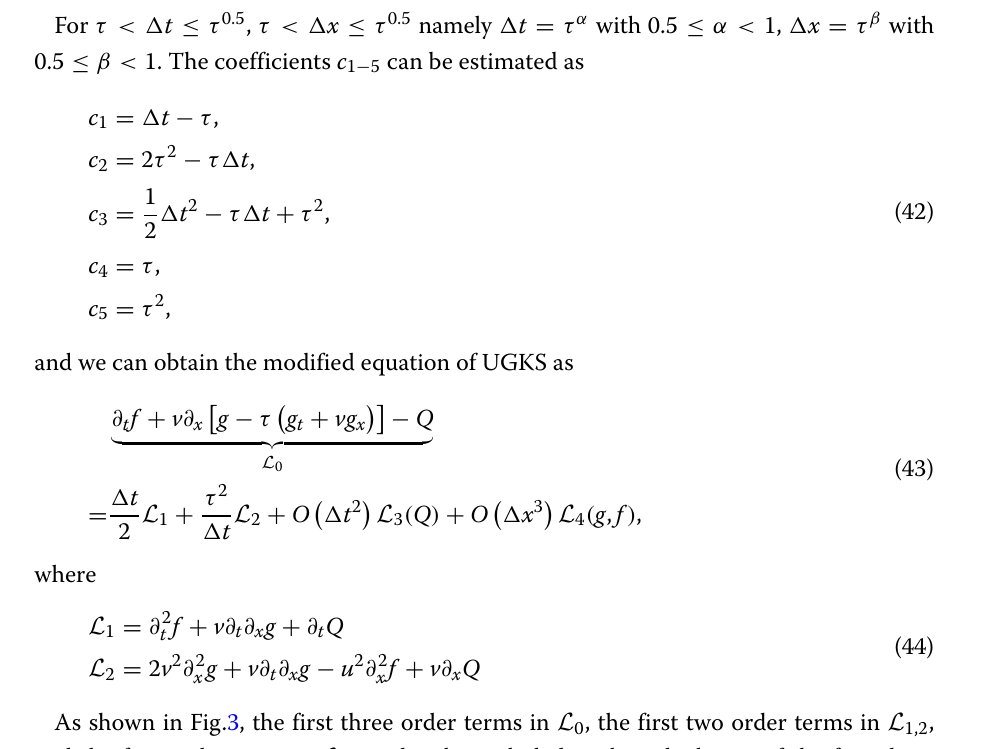
Fig.2 OrdersequenceofthemodifiedEq.40. L 0 axisshowstheordersequenceofthetopthreeordertermsin L 0 , L 1 axis shows the order sequence of the top three order terms in τ need to be included in the calculation of the first three asymptotic expansions of the modified equation